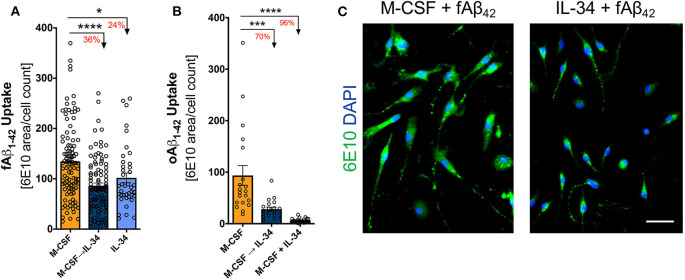
IL-34 reduces fibrillar and oligomeric Aβ42 uptake by macrophages. Quantitative ICC analyses assessing the extent of fibrillar (A) and oligomeric (B) f/oAβ42 uptake by 6E10 staining. In both f/oAβ42 phagocytosis assays, macrophages exposed to IL-34 during any phase of differentiation demonstrated reduced Aβ42 uptake compared to the M-CSF condition. (C) Representative images demonstrating reduced fAβ42 uptake by IL-34-treated macrophages. Scale bar: 50 μm. *P < 0.05, ***P < 0.001, ****P < 0.0001 by one-way ANOVA with Tukey's post-test.